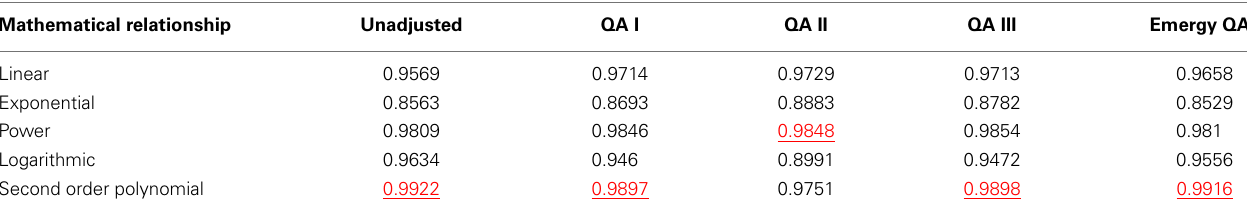
Table 4 |The R -squares of mathematical relationships between measures of the energy and quality adjusted (QA) energy consumed (Y) and total emergy use (X)